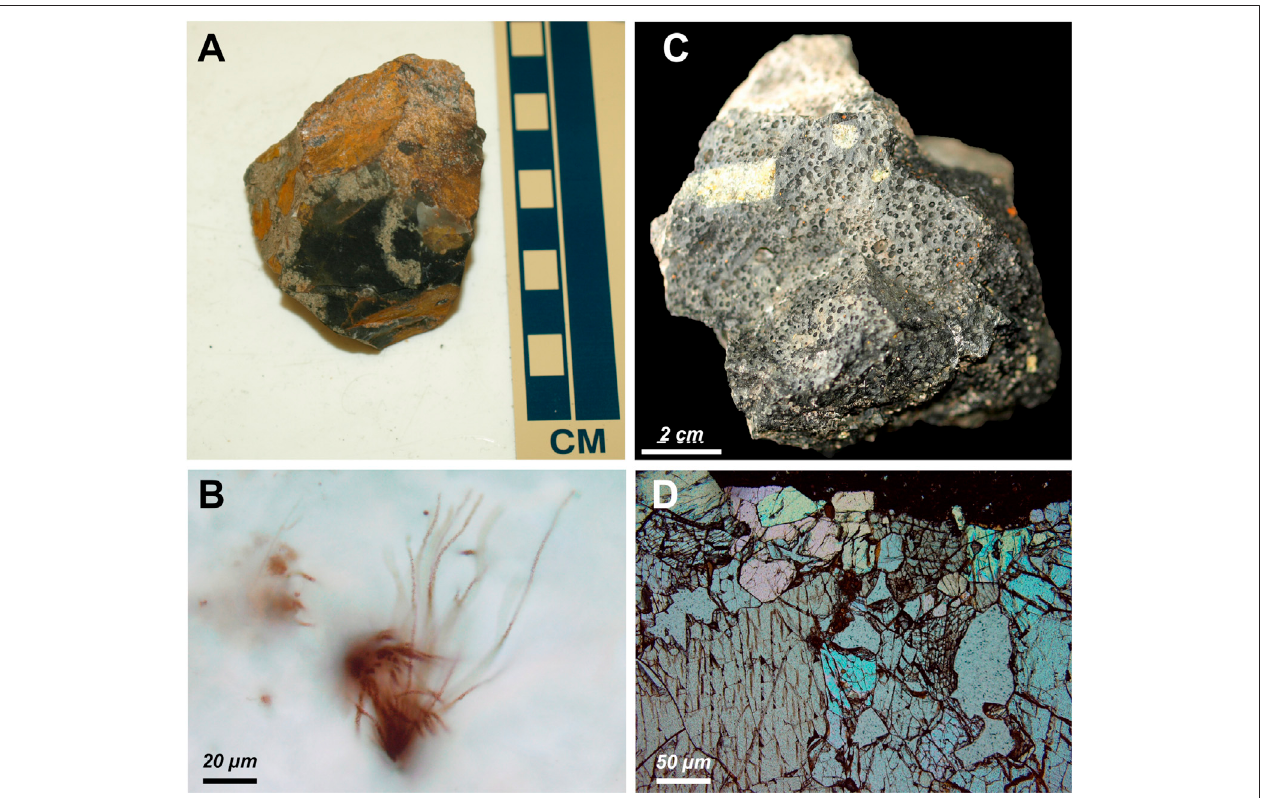
FIGURE1|(A) Photograph ofahandsampleofchertfrom the1.9 billionyears oldGun fl intFormation, Canada, and (B) image inopticalmicroscopyintransmitted light of the associated thin section permitting observation of microfossils otherwise impossible to see. (C) Basalt from Svalbard and (D) microscope observation of the associated thin section in cross-polarized transmitted